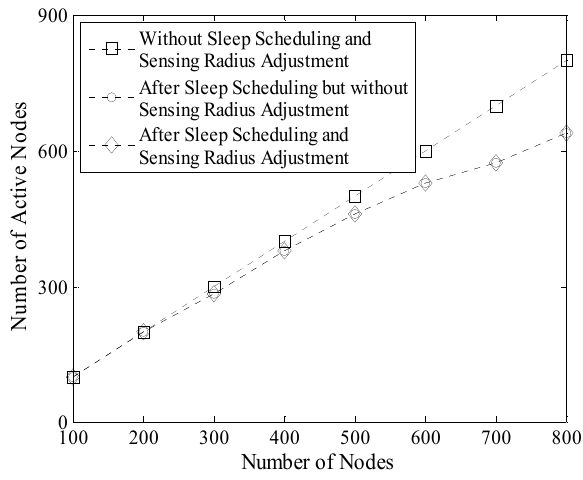
Figure 17. Number of active nodes in LDGM (200 m × 200 m).